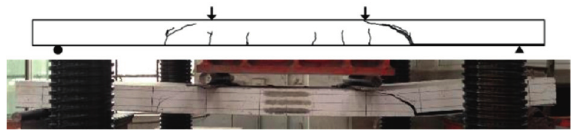
Figure 11: Deformation and crack distribution in